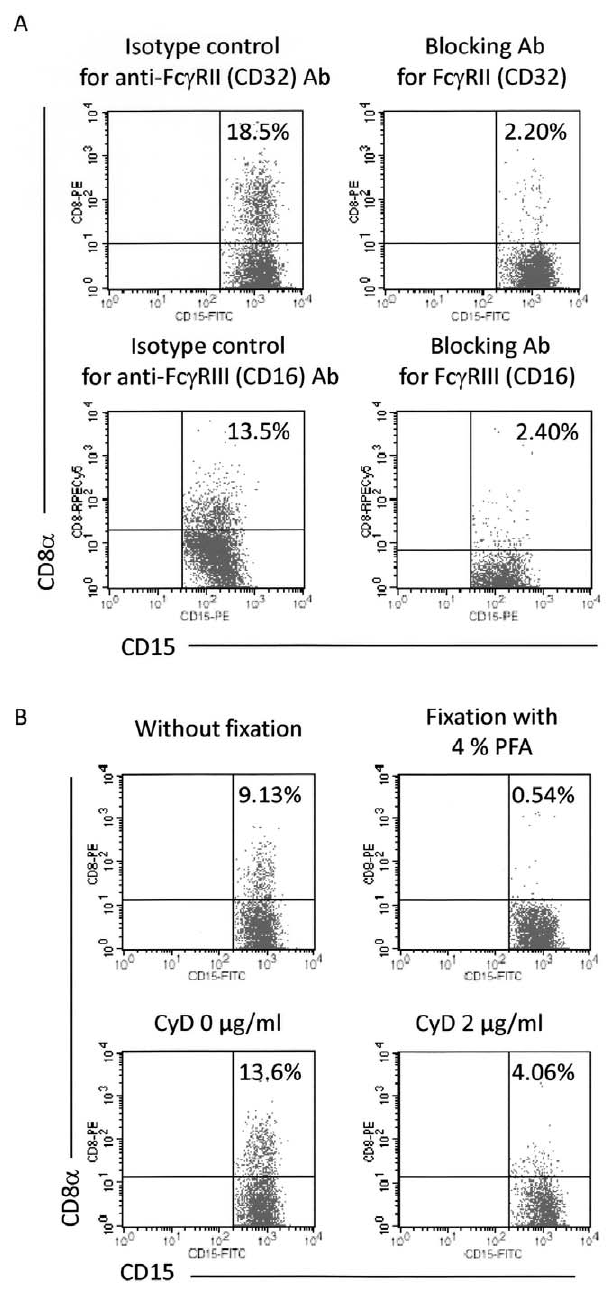
Figure 3. Requirement of Fc c Rs, dynamism of plasma mem- brane, and actin recruitment in detection of CD8 + granulo- cytes. ( A ) Involvement of Fc c RII (CD32) and Fc c RIII (CD16) in the detection of CD8 + granulocytes. Heparinized blood samples were pre- incubated with the anti- Fc c RII (CD32) Ab (AT10) or with the anti-Fc c RIII (CD16) Ab (3G8). After the pre-incubation, the samples were made to react with the PE or PECy5-labeled anti-CD8 a Ab (HIT8a). After depletion of erythrocytes, the cells were re-suspended in PBS followed by reaction with the FITC or PE-labeled anti-CD15 Ab (H198), and then served for FCM. PE or PECy5-labeled mouse IgG1 and FITC or PE-labeled mouse IgM were used as isotype-matched controls for HIT8a and H198, respectively. ( B ) Effects of plasma membrane fixation and inhibition of actin recruitment in the detection of CD8 + granulocytes. PMNs and PBMCs were mixed together. For fixation of the plasma membrane, the cells were exposed to 4% PFA for 10 min at room temperature. After washing 3 times with PBS, the cells were re-suspended in